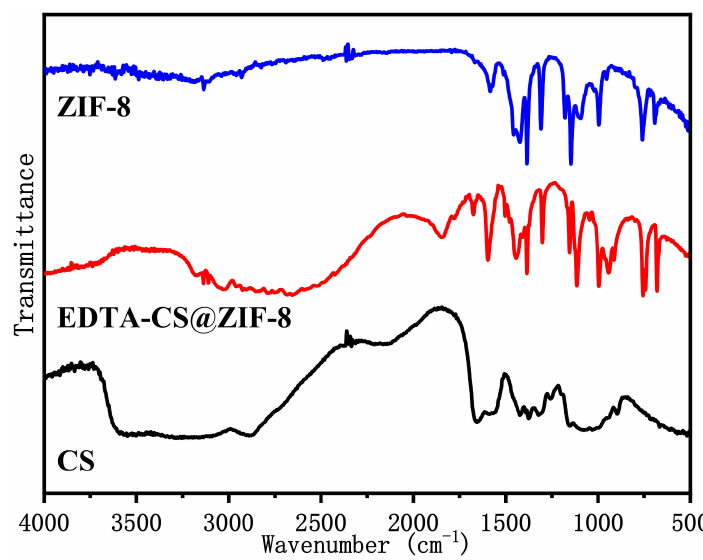
Figure 2. FT-IR of ZIF-8, chitosan, and EDTA–CS@ZIF-8.